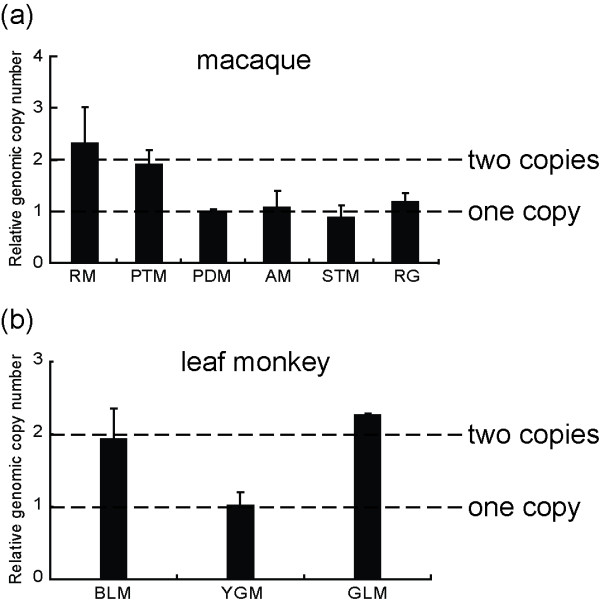
The result of genomic DNA qPCR in macaques (a) and leaf monkeys (b). (a) RM and PTM showed about 2 fold of RHOXF2 gene genomic DNA compared to the other macaques. (b) BLM and GLM showed about 2 fold of RHOXF2 gene genomic DNA compared to YGM. The single copy X-linked gene, transketolase-like 1 (TKTL1) is the reference gene. For the abbreviations of the tested primate species, refer to table 1.